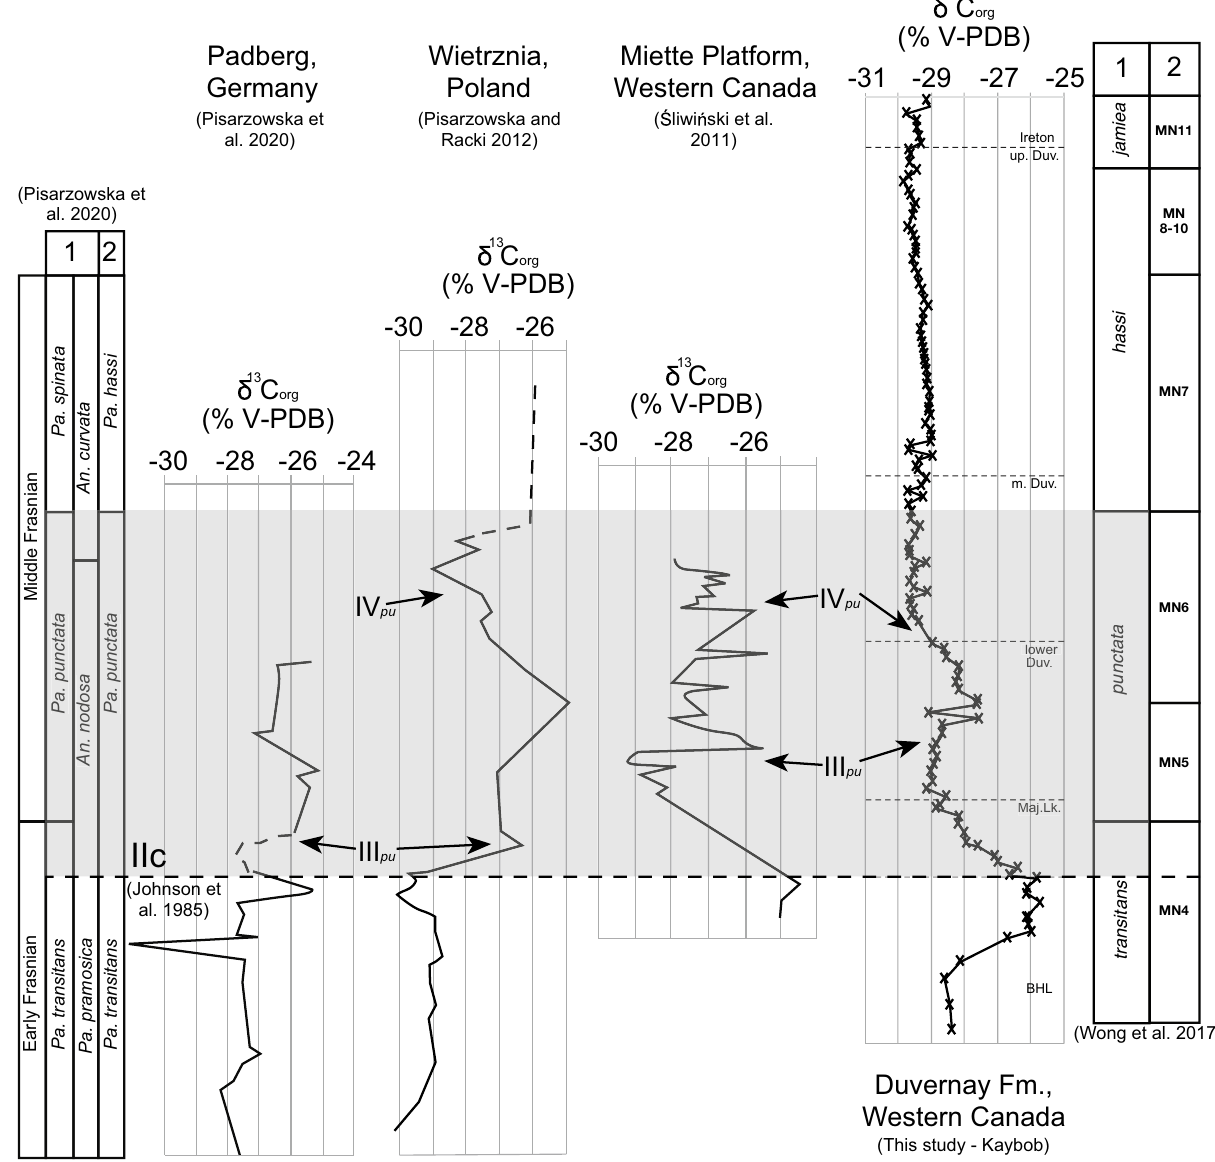
Figure 6. δ 13 C (org) records from Padberg, Germany 12 , Wietrznia, Poland 52 , western Canada (Miette Platform) 18 , and this study of the Duvernay Formation from western Canada. These records are plotted with the biostratigraphic column from Pisarzowska et al. 12 (1 = revised conodont zonation in Pisarzowska et al. 12 and 2 = Racki and Bultynck 53 ) and Wong et al. 31 (1 = Ziegler and Sandberg 54 and 2 = Montagne Noire Zone 55